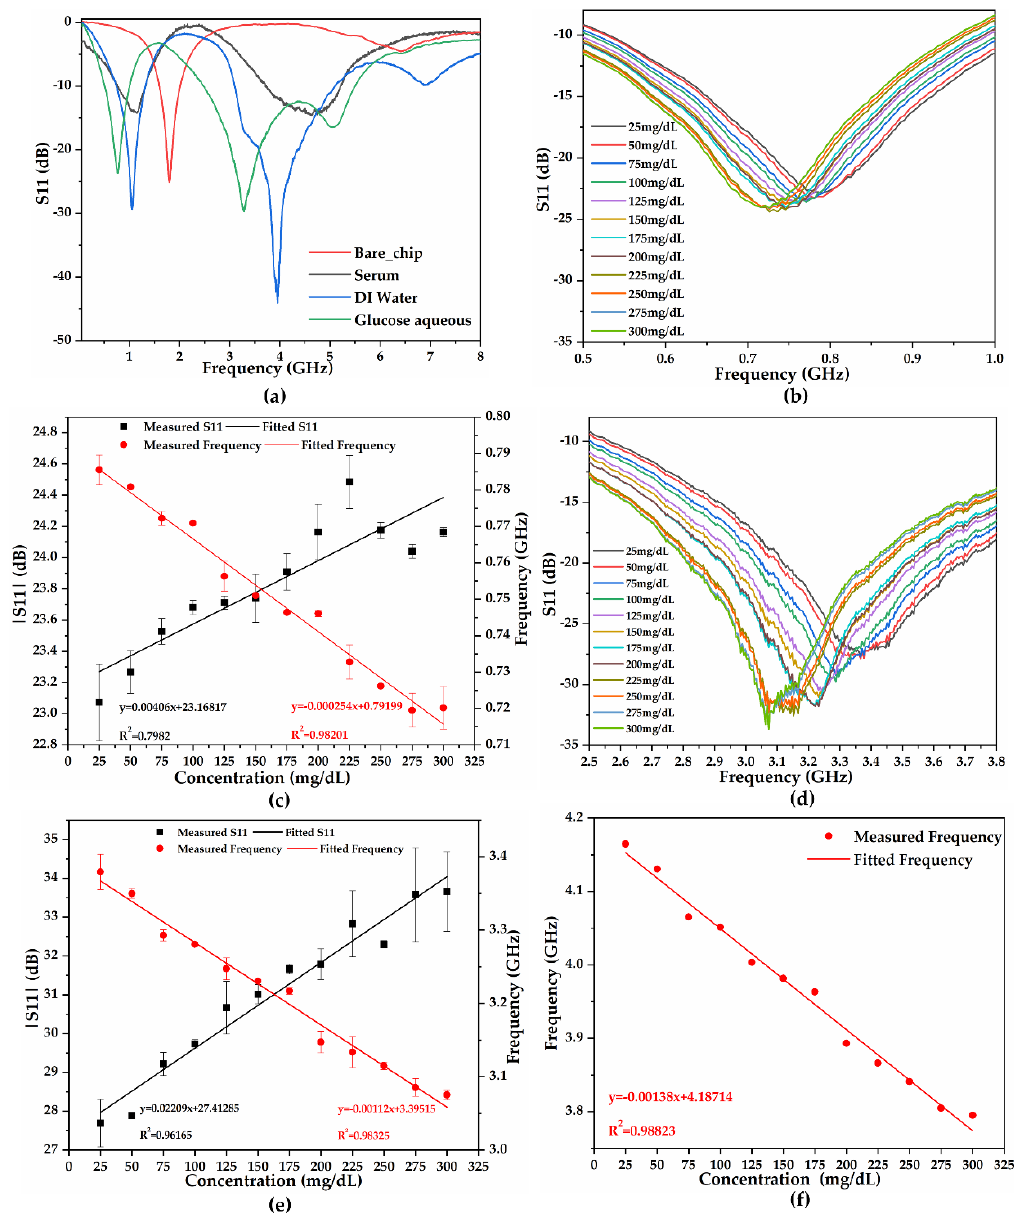
Figure 6. Microwave response under various conditions: ( a ) DI water, serum, and 100 mg/dL glucose aqueous responses compared with the unloaded chip; ( b ) resonant frequency responses of various concentrations at peak 0.8 GHz; ( c ) the linear analysis at 0.8 GHz peak of multiple concentrations with error bars; ( d ) the peak response at 3.2 GHz to multiple concentrations; ( e ) the linear analysis at 3.2 GHz peak of multiple concentrations with error bars; ( f ) summation of the relationship between two peak conditions at various concentrations.